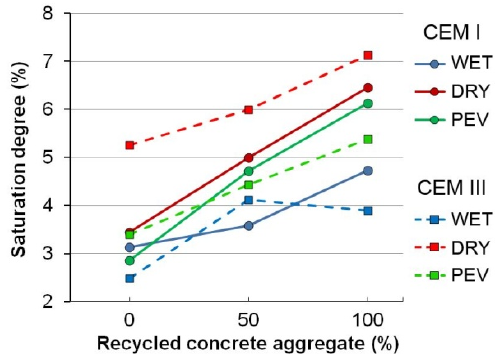
Figure 7. Saturation degree of concrete.